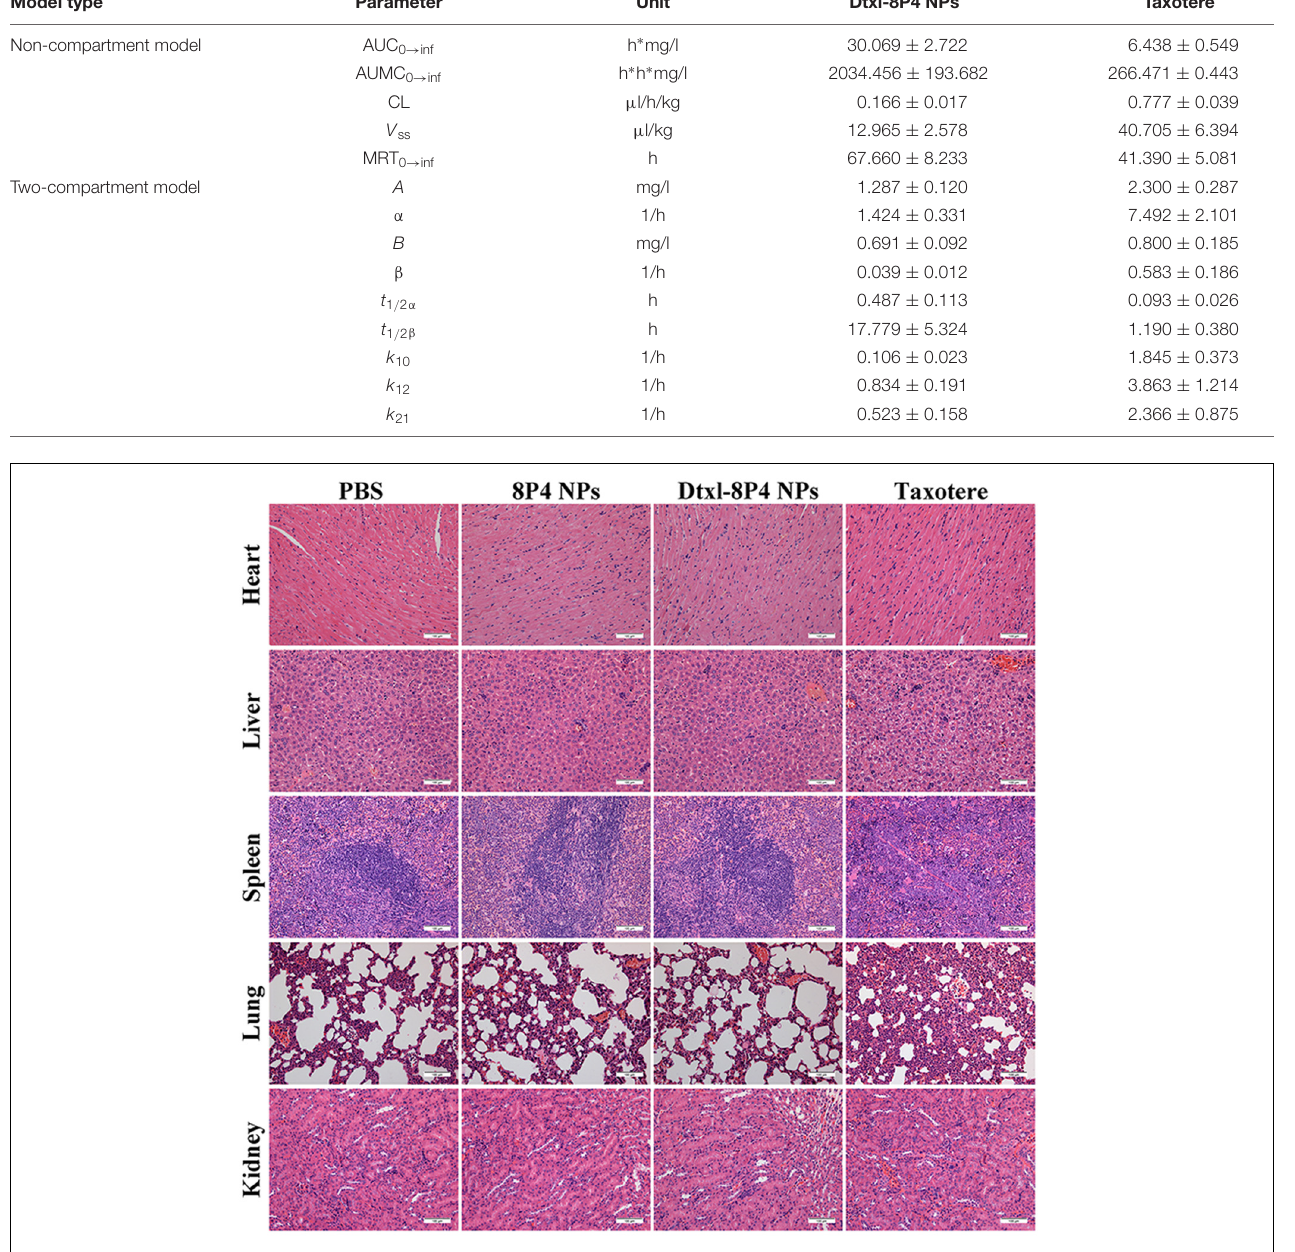
FIGURE 6 | Histopathological analysis of major organs from BALB/c mice ( n = 5 per group) treated with PBS, 8P4 NPs, Dtxl-8P4 NPs, and Taxotere (20 × objectives).